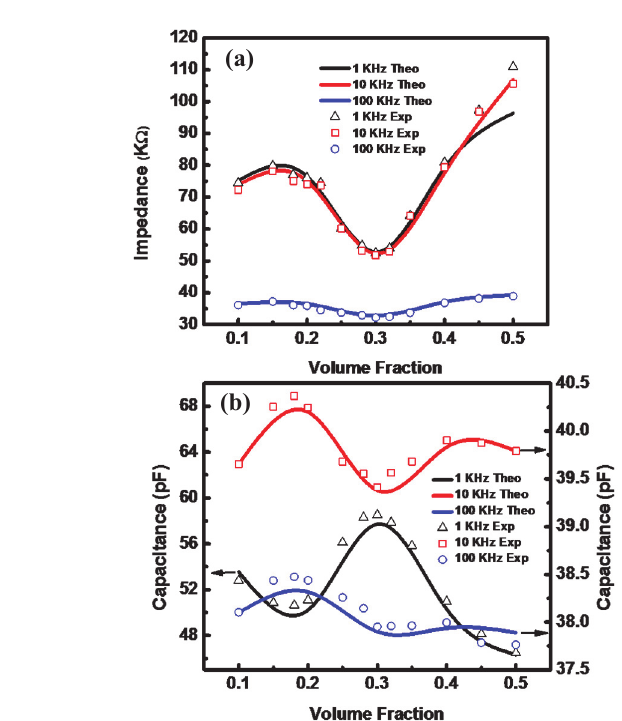
Fig. 5: (a) Comparative plots of both experimental and theoretical variation of impedance with volume fraction at 1 kHz, 10 kHz and 100 kHz and; (b) comparative plots of both experimental and theoretical variation of capacitance with volume fraction at 1 kHz, 10 kHz and 100 kHz.